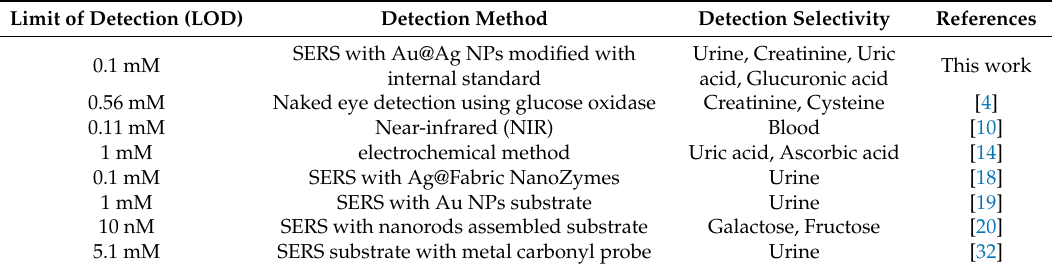
Figure 7. ( a ) The SERS spectra of different concentration glucose detected by using MPBA-modified Ag nanoparticles; ( b ) the linear correlation of Raman peak intensity at 1177 cm − 1 and the concentration of glucose. Table 1. Comparison of sensing performance for different detection methods.